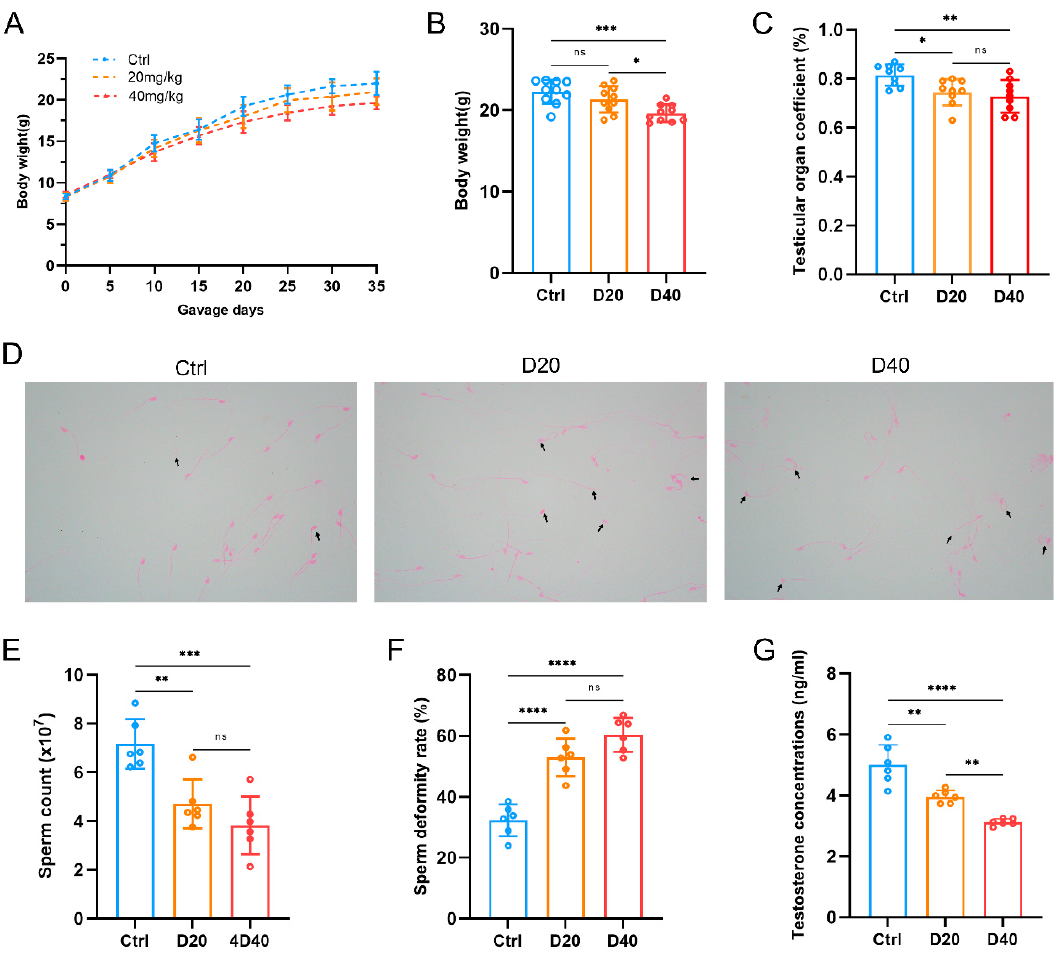
Figure 1. DFZ exposure induces testicular injury. ( A ) Temporal graph of body weight, ( B ) body weight at the completion of treatment, ( C ) testicular organ coefficient, ( D ) sperm morphology (black arrows denote the malformed sperm), ( E ) sperm counts, ( F ) sperm deformity rate, and ( G ) serum testosterone concentration in different groups. * p < 0.05, ** p < 0.01, *** p < 0.001, **** p < 0.0001, ns. indicates not statistically significant versus the control group.